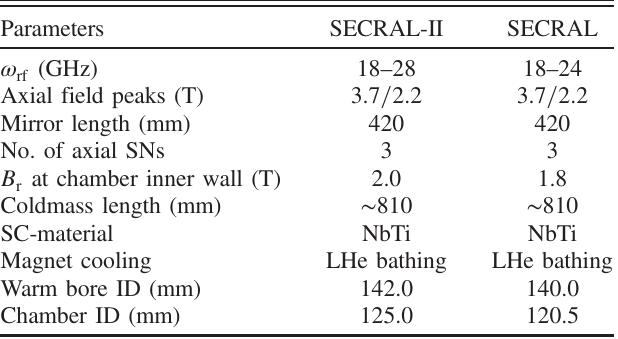
TABLE I. Main design parameters of SECRAL-II and SECRAL ion